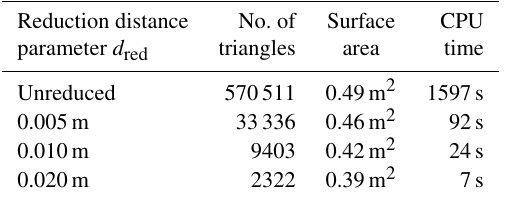
Table 1. Number of triangle surface elements of the IR calibrator 3D thermogram after the reduction using different distance param- eter values in the reduction algorithm, resulting surface area of the triangles, and CPU time needed (Intel